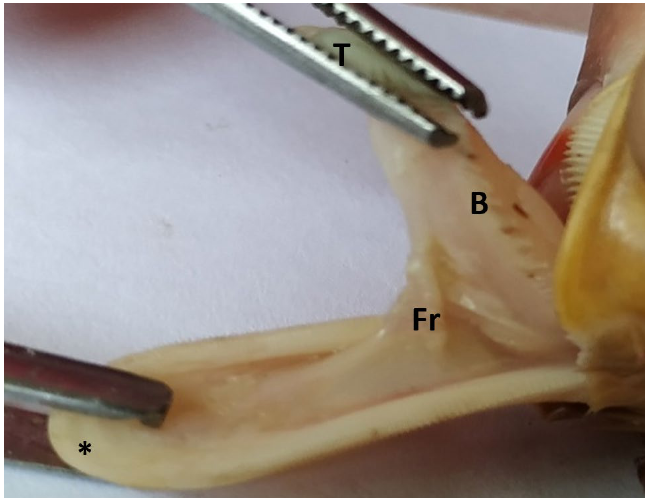
Fig. 1. Photograph of the ventral surface of the tongue and the lower beak of the Khaki Campbell duck on day one showing the free tip of the lower beak (Star), the tip of the tongue (T), a body of the tongue (B), and frenulum linguae (Fr)